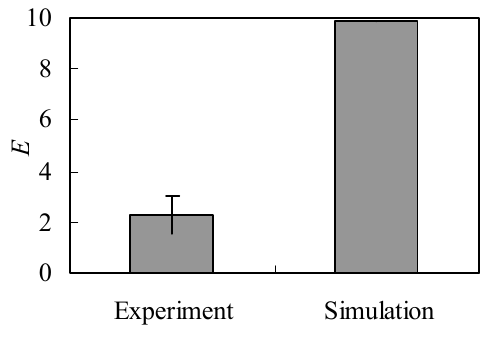
Fig. 13 Time history of measured EMG ( Thick line : average, Thin Line : average ± standard deviation )